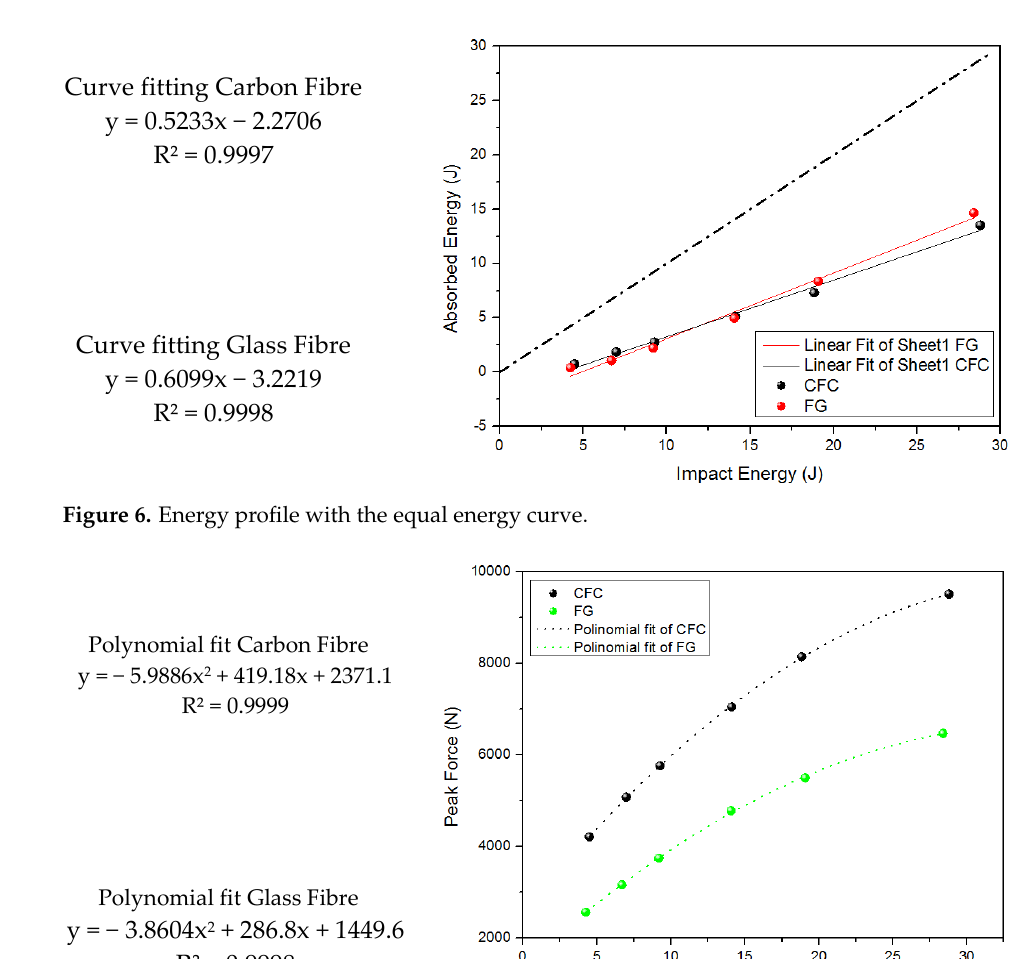
Figure 7. Peak force as a function of the impact energy for the carbon fibers (black) and glass fibers (green).